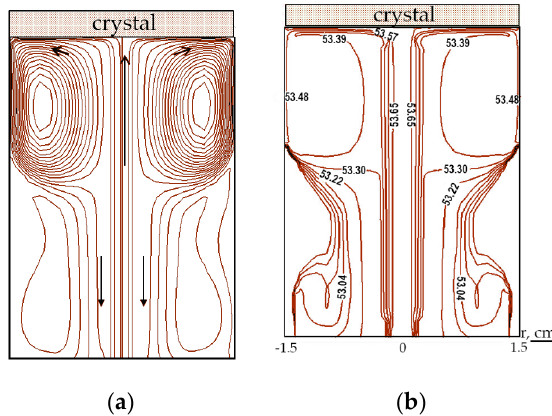
Figure 3. Central solution supply: ( a ) streamlines of laminar flow; ( b ) KCSH concentration isolines (g/1000 g H 2 O) at V jet = 90 cm/s.